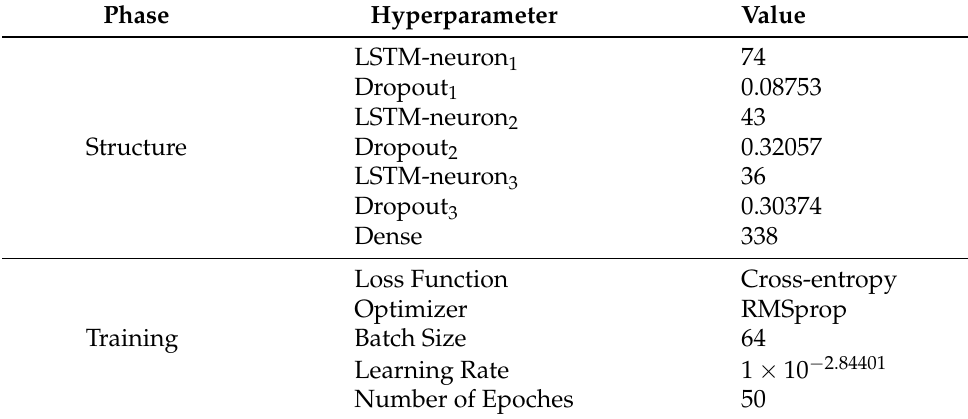
Table 5. The summarized hyperparameters of 3-Stacked LSTM Network found by SigOpt.